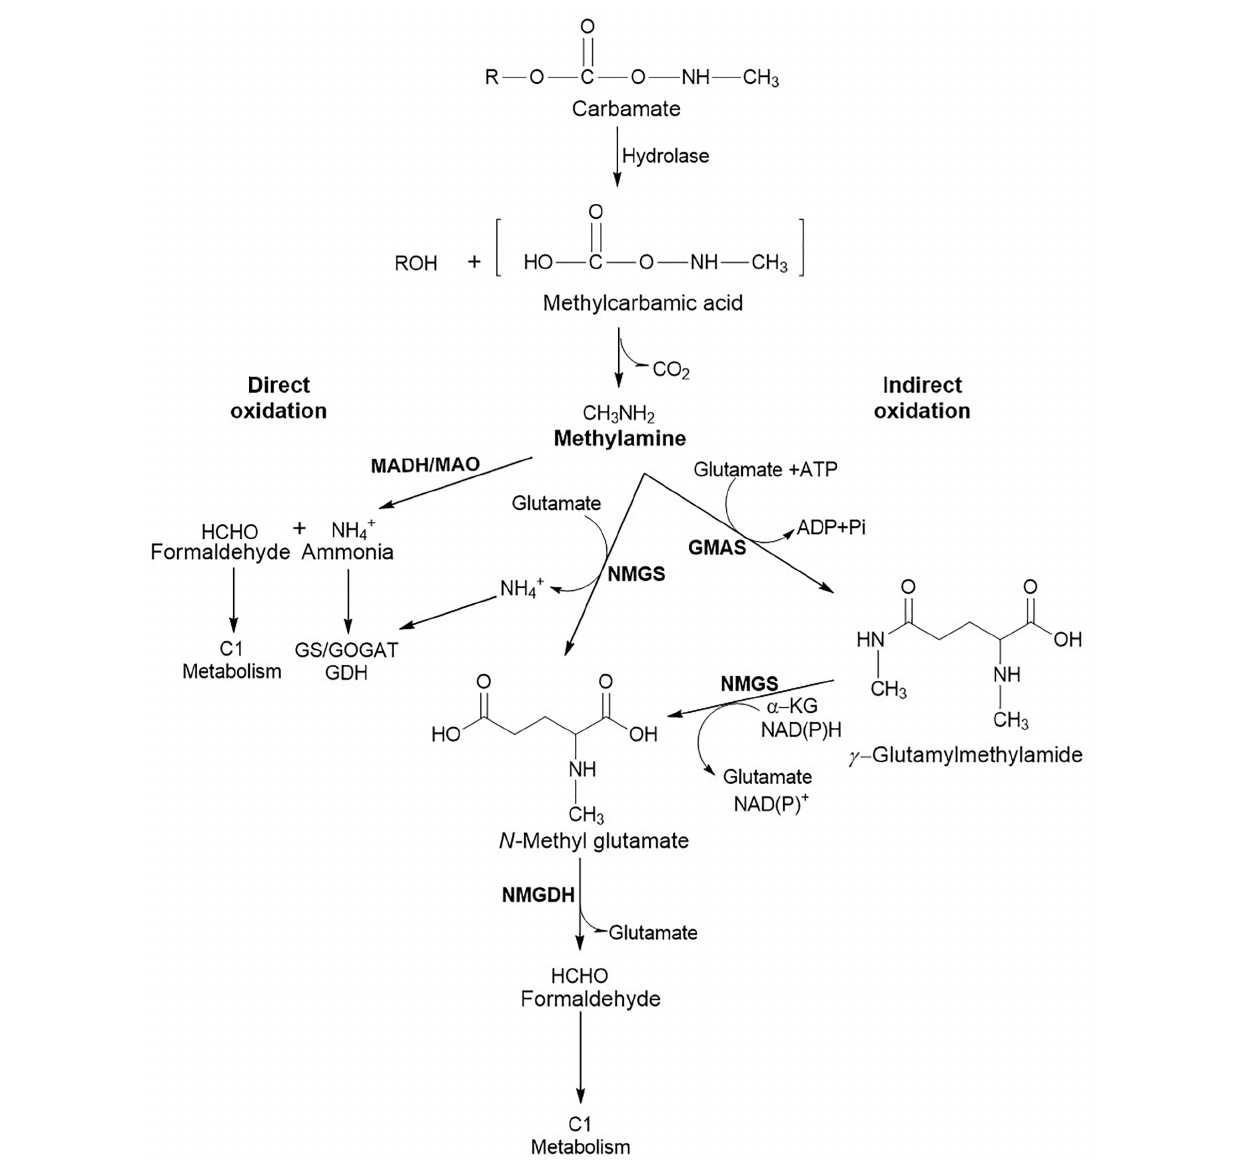
FIGURE 5 | Metabolic routes involved in methylamine utilisation. The direct oxidation route involves MADH, Methylamine dehydrogenase in Gram negative and MAO, Methylamine oxidase in Gram positive bacteria. Indirect oxidation involves enzymes like NMGS, N -Methylglutamate synthase; GMAS, Glutamylmethylamide synthetase; and NMGDH, N -Methylglutamate dehydrogenase. Ammonia generated is utilised through the Glutamine synthetase/Glutamine oxoglutarate aminotransferase (GS/GOGAT) or Glutamate dehydrogenase (GDH) route, whereas formaldehyde is utilised through C1 metabolic